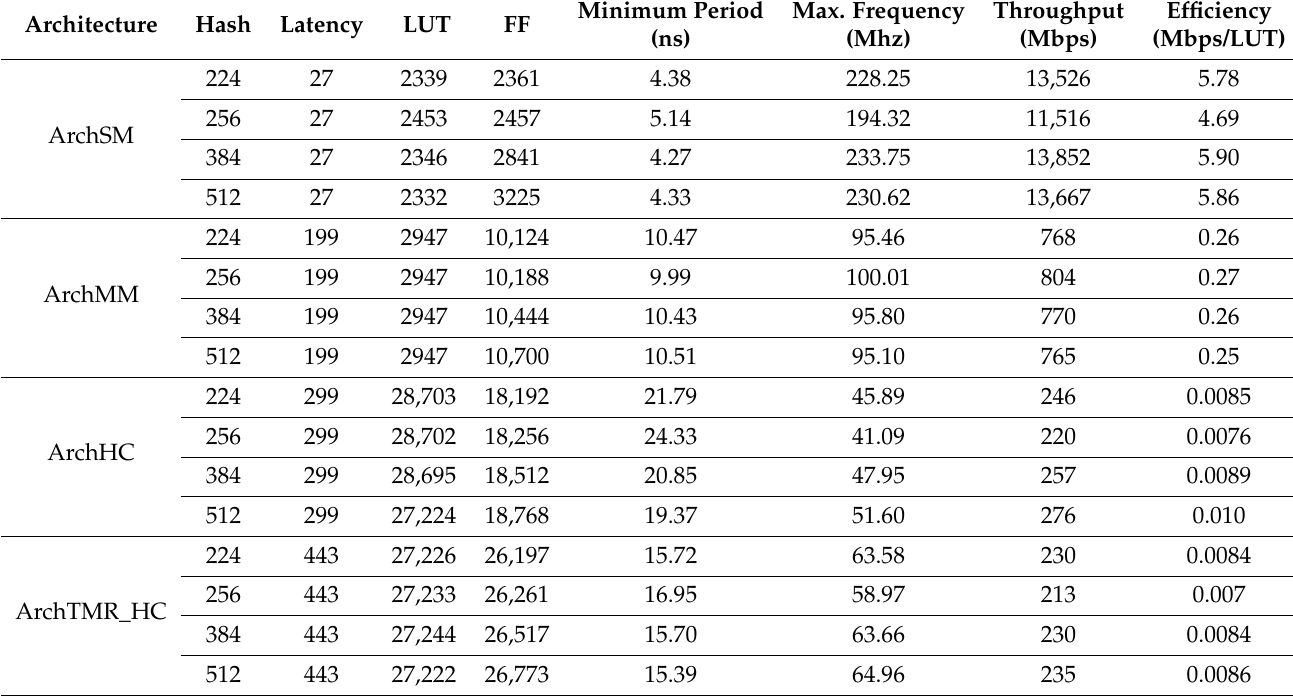
Table 3. Results comparison of SHA-3 hardware architectures without and with fault